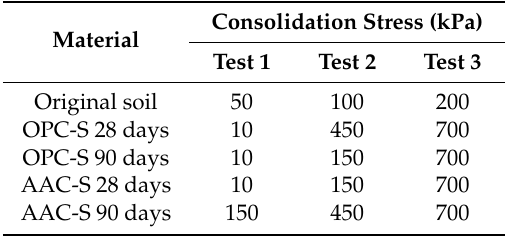
Table 5. Consolidation stresses for the triaxial